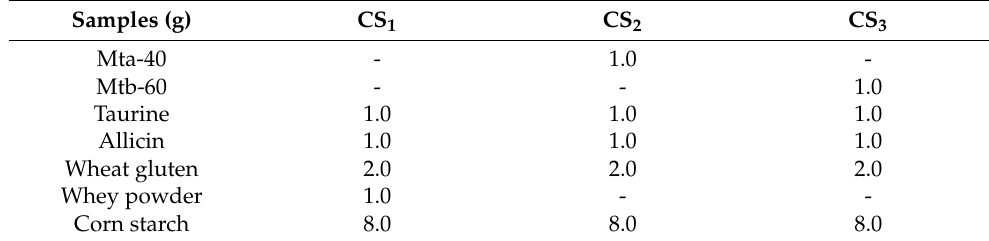
Table 1. The synthesis steps of nanocomposite films. Samples